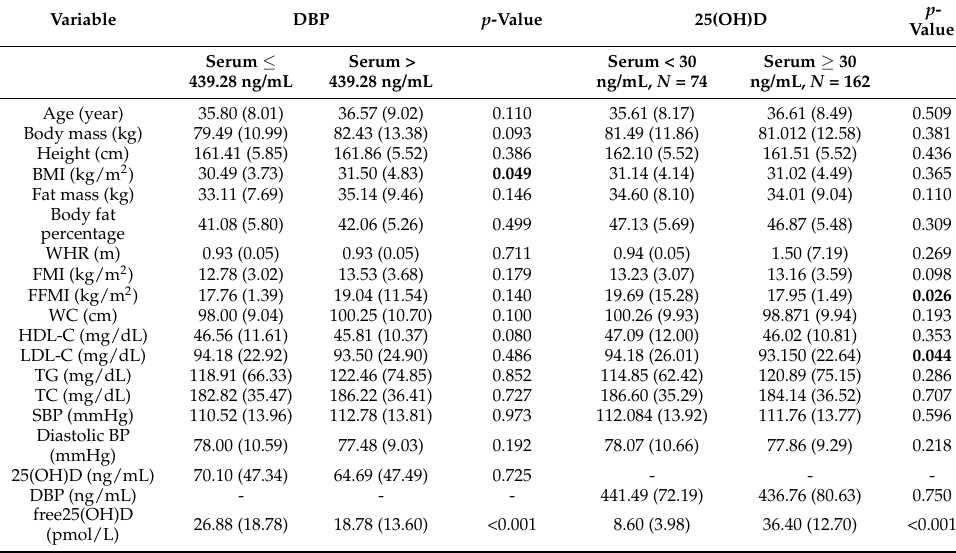
Table 2. Anthropometric characteristics, blood pressure, and lipid profile of the studied population, grouped based on DBP (nmol/L) and 25(OH)D concentration